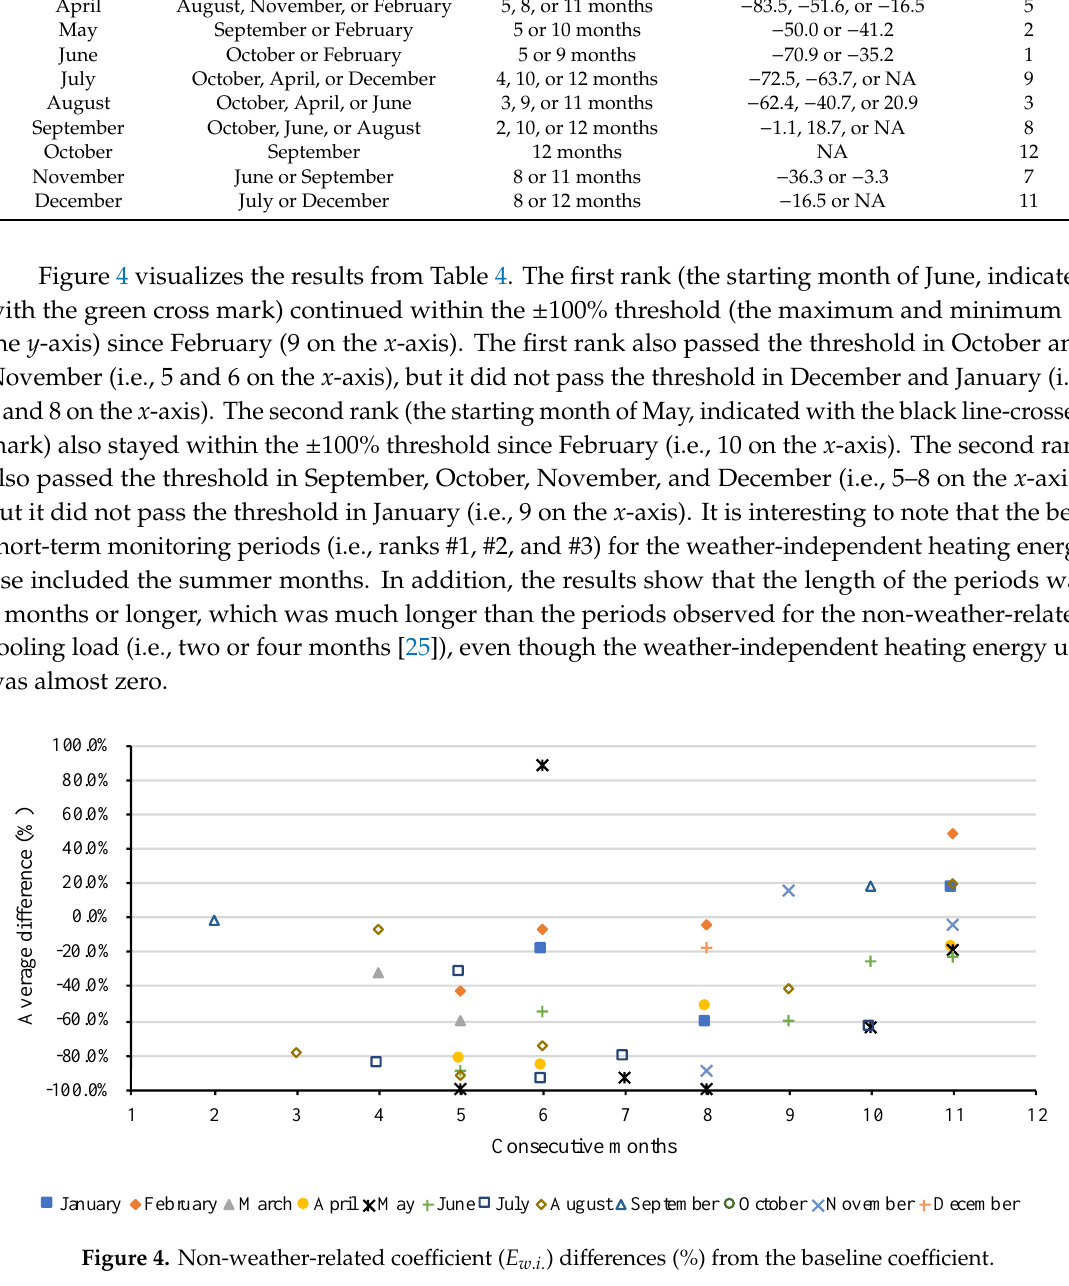
Figure 4. Non-weather-related coefficient ( 𝐸 𝑤.𝑖. ) differences (%) from the baseline coefficient.